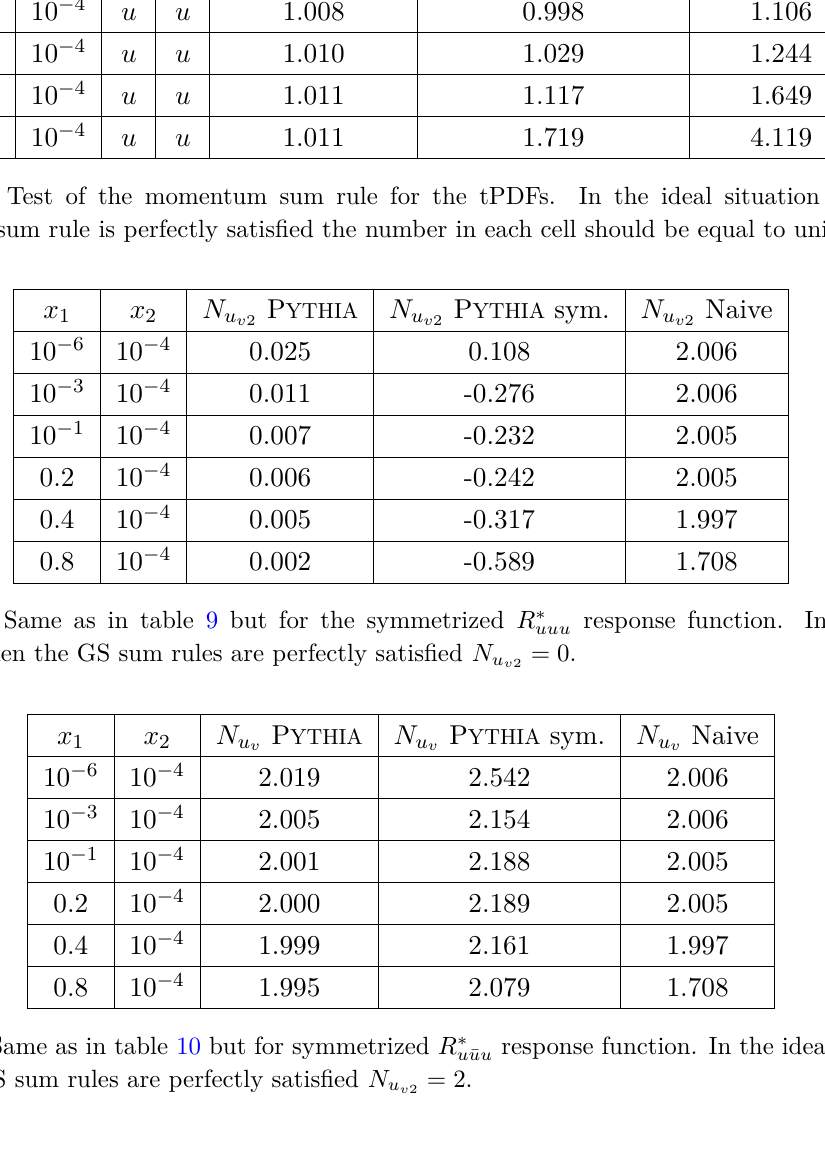
Table 13 . Same as in table 10 but for symmetrized R ∗ when the GS sum rules are perfectly satisfied N u